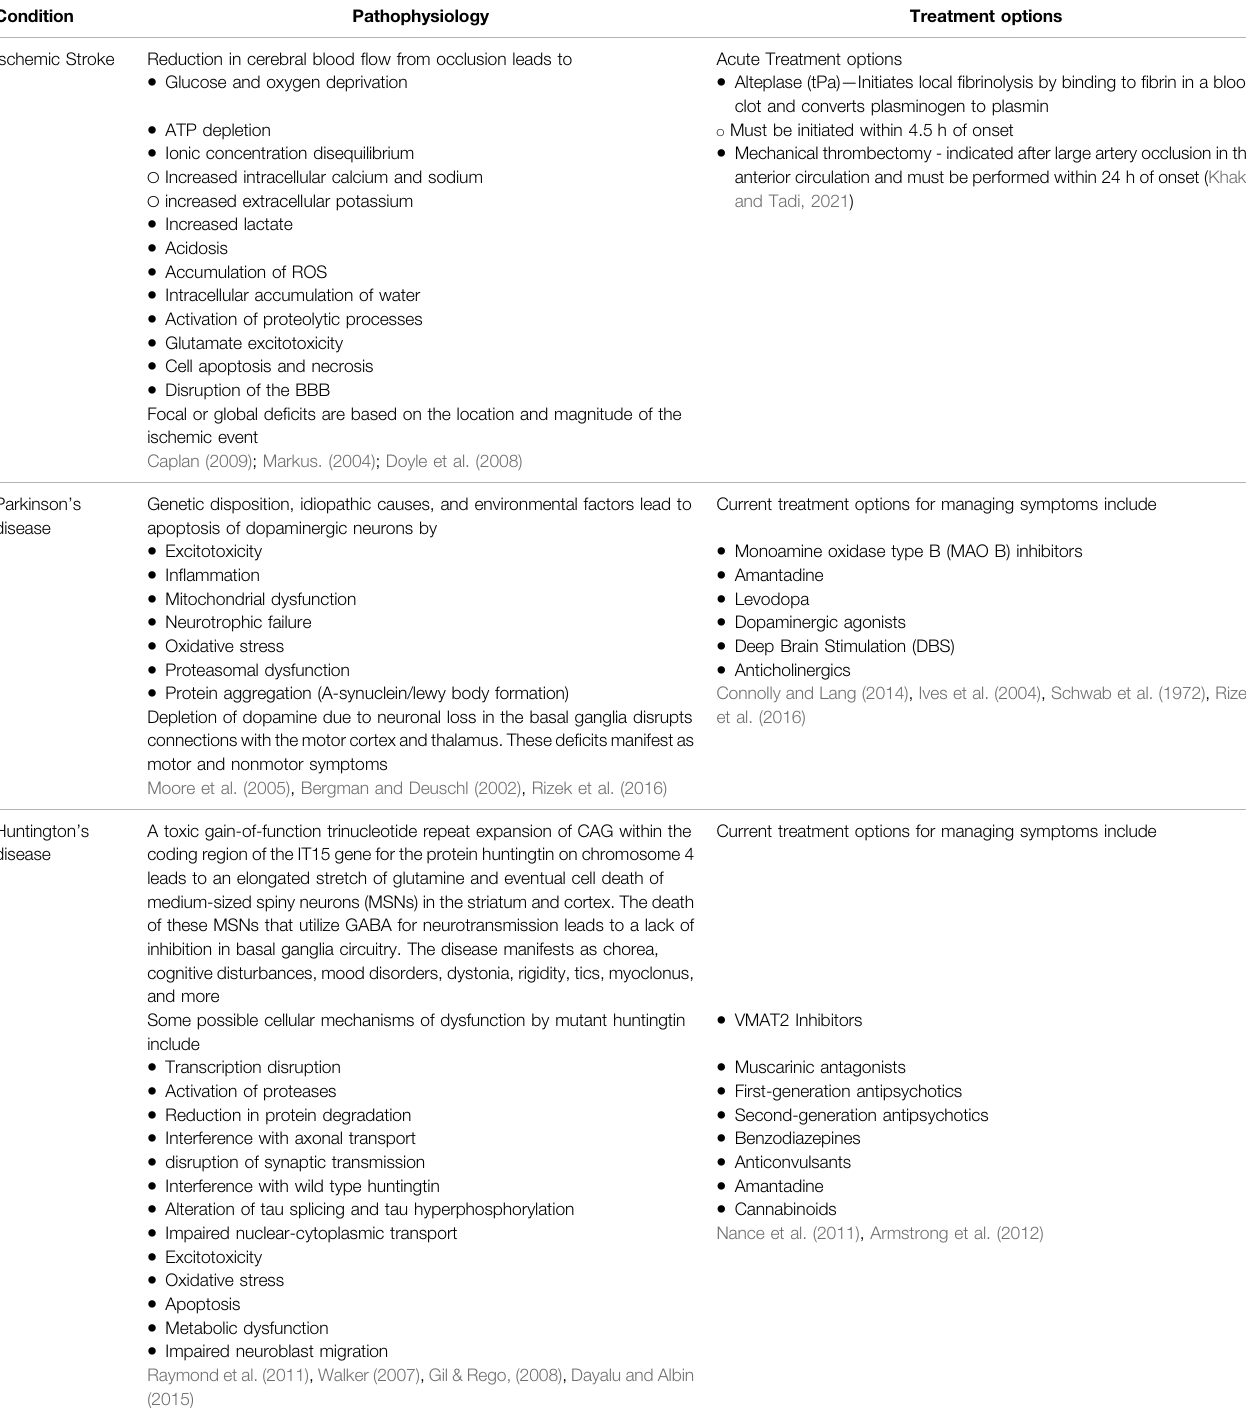
TABLE 1 | The pathophysiology and common treatment options for ischemic stroke, Parkinson ’ s disease, and Huntington's disease. Condition Pathophysiology Treatment options Ischemic Stroke